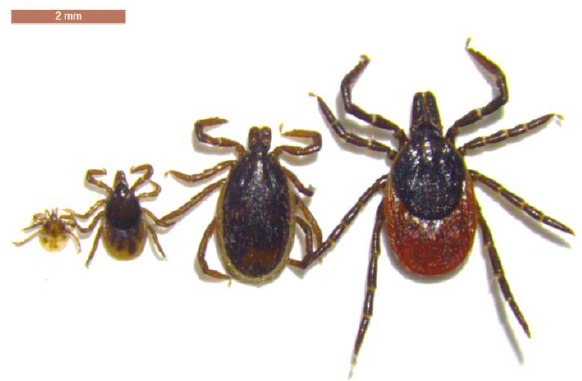
Figure 4. Three active life stages of Ixodes ricinus (from left: larva, nymph, adult (male, female)).